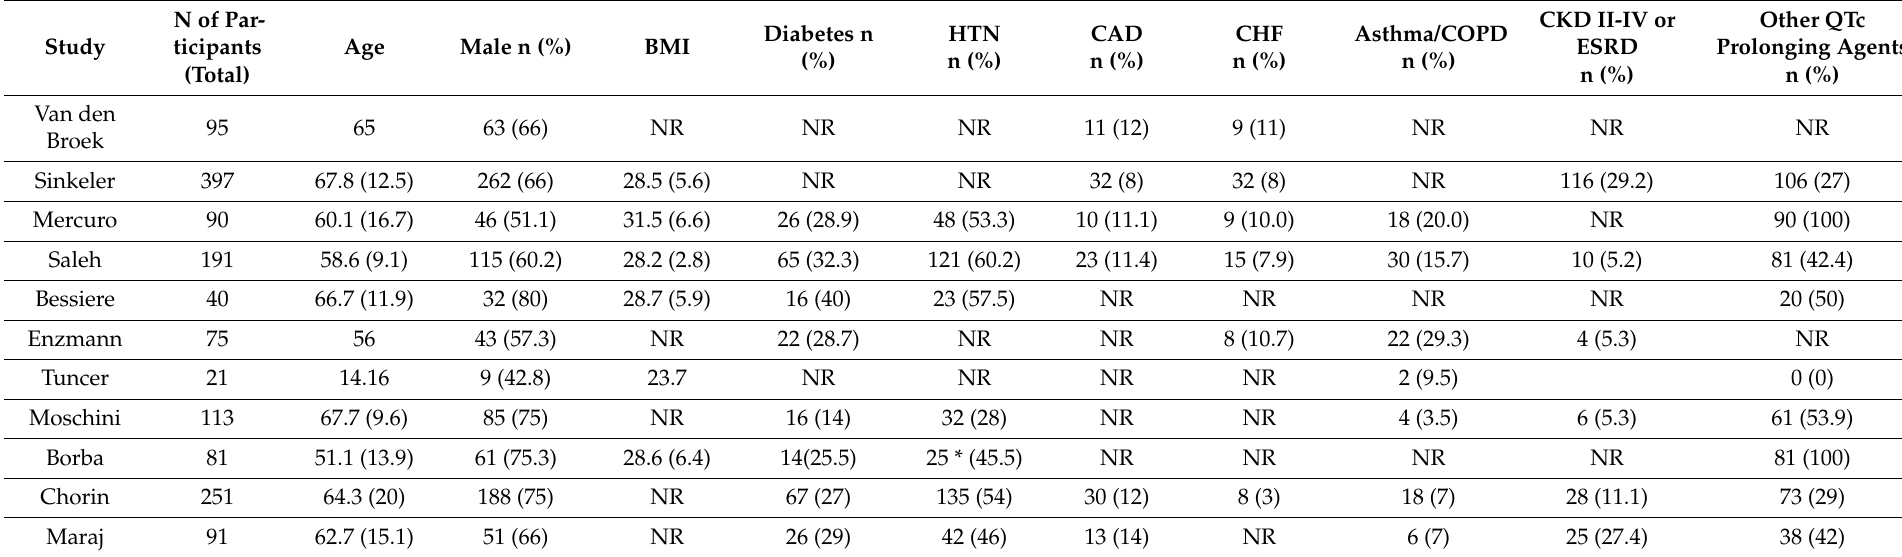
Table 2. Baseline characteristics of patients per included